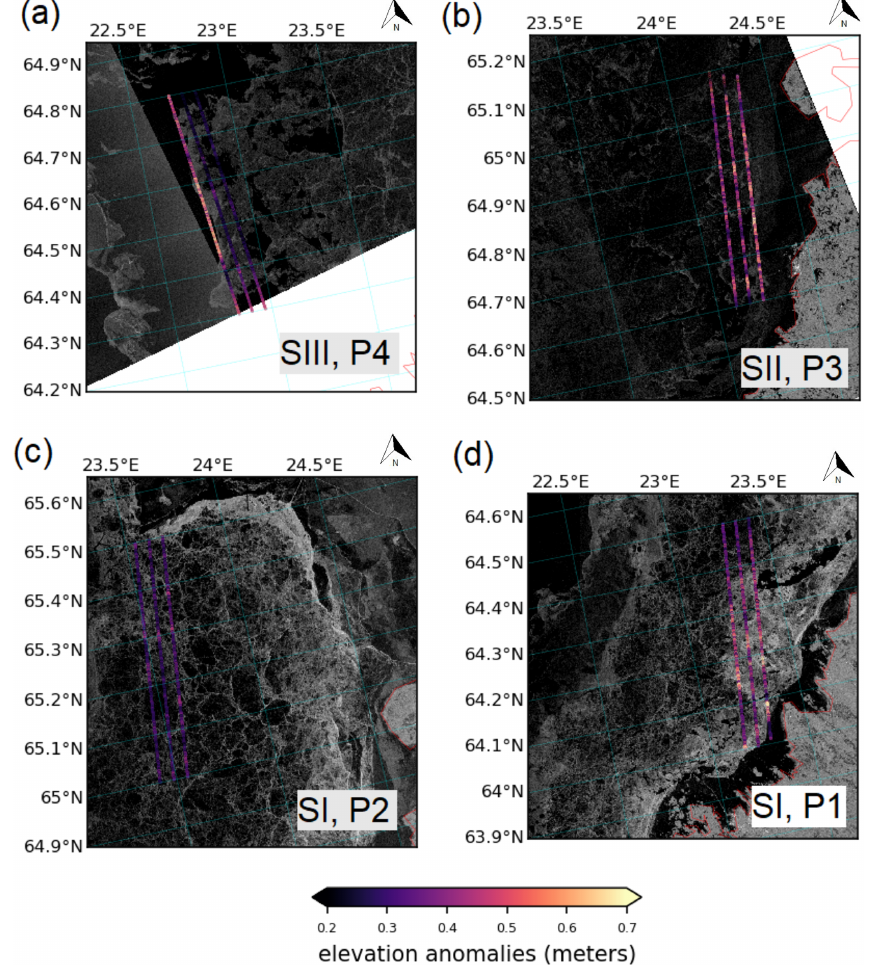
Figure 6. Elevation anomalies overlaid on an S1 SAR image (SI–SII in HV polarisation) for four cases (see Tables 1 and 3 for specifications; the figures represent the (a) case for Region E on 17 February 2019, (b) case for Region J on 23 March 2019, (c) case for Region L on 27 March 2019, and (d) case for Region B on 27 March 2019; P1–P4 highlight the relative photon profiles to be found in Fig. 7). Strong backscatter (white areas in SAR image) is usually perceived as deformed ice in HV polarisation.